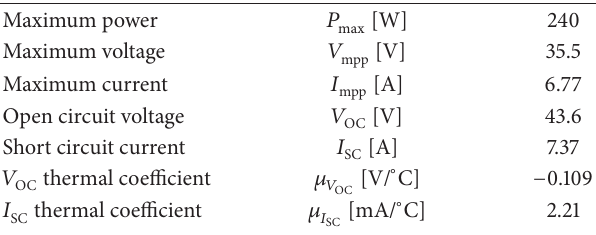
Table 2: Data sheet of Sanyo